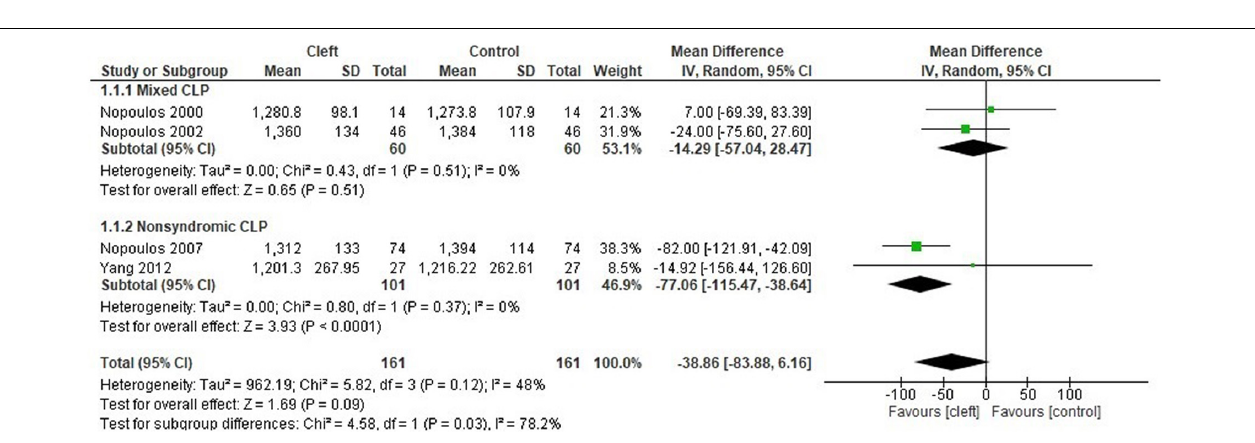
FIGURE 2 | Forest plot for total brain gray matter volume (cm 3 ).